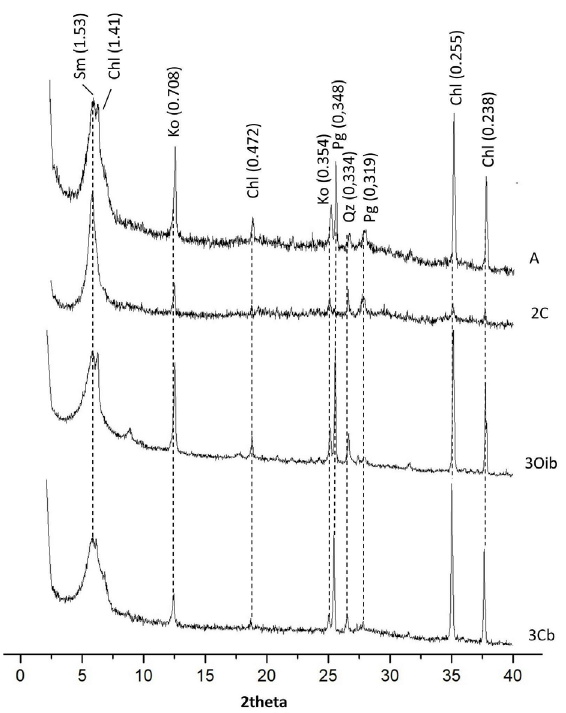
Figure 4. XRD spectrum of clay fraction within the pedon P4 (MT-3). Chl: chlorite, Sm: smectite, Pg: plagioclase, Qz: quartz, Le: Leucophosphite, Str: Struvite. “d” in